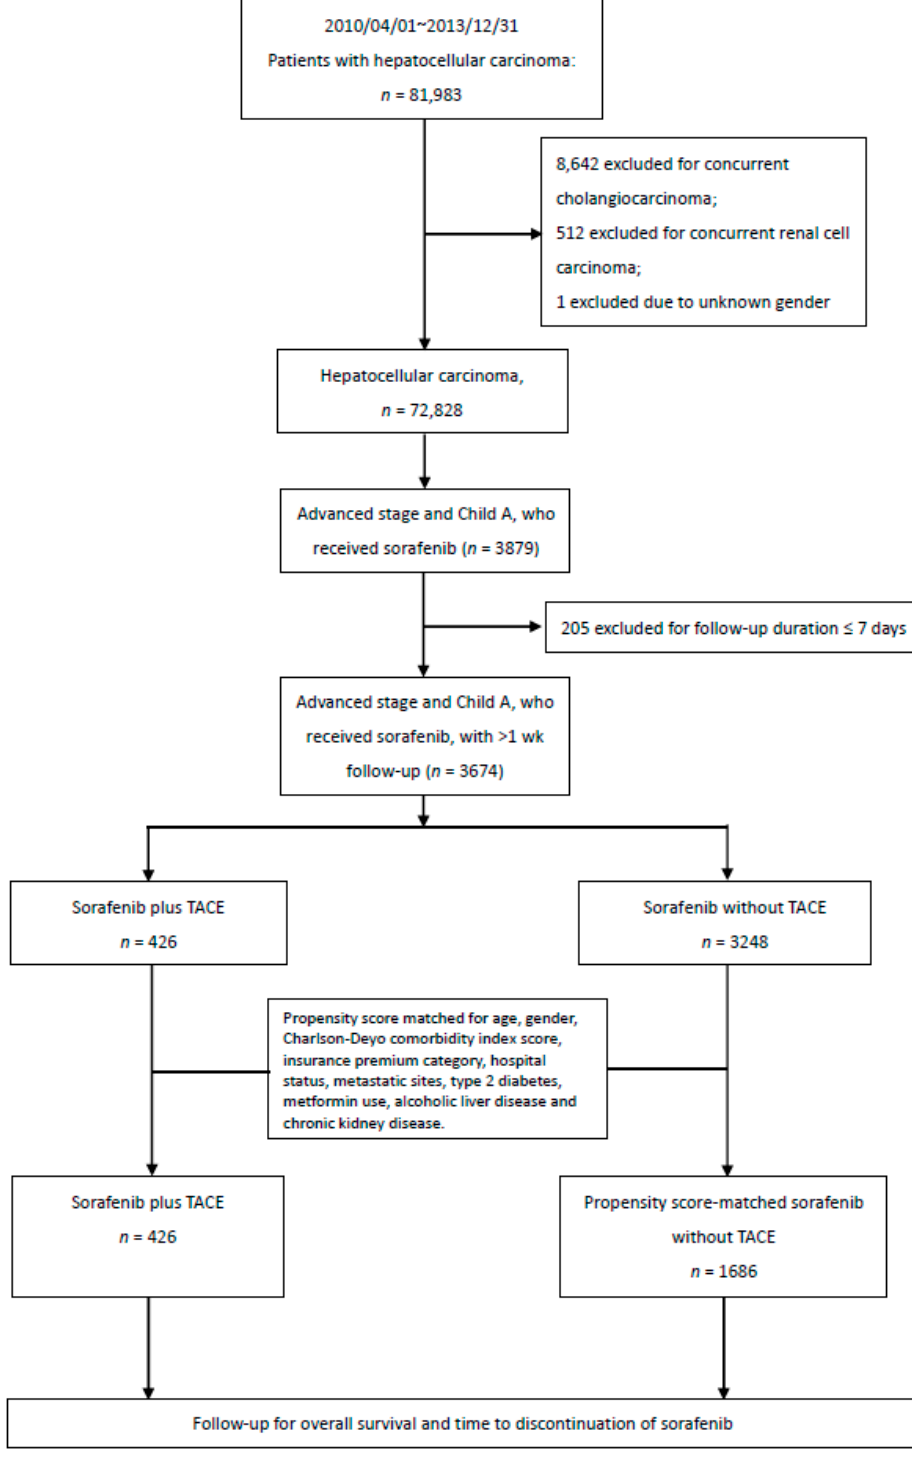
Figure 1. Consort diagram of the study flow towards the final cohort of 2,112 patients.